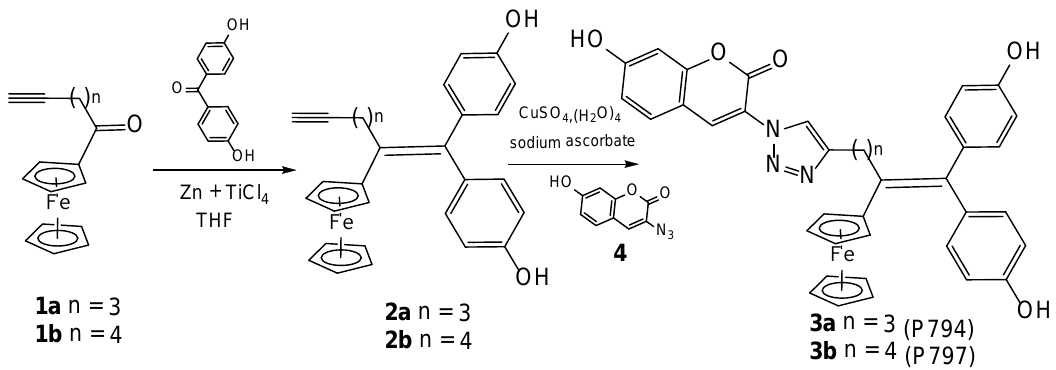
Scheme 1. Synthesis of ferrociphenol coumarin dyads P794 and P797.